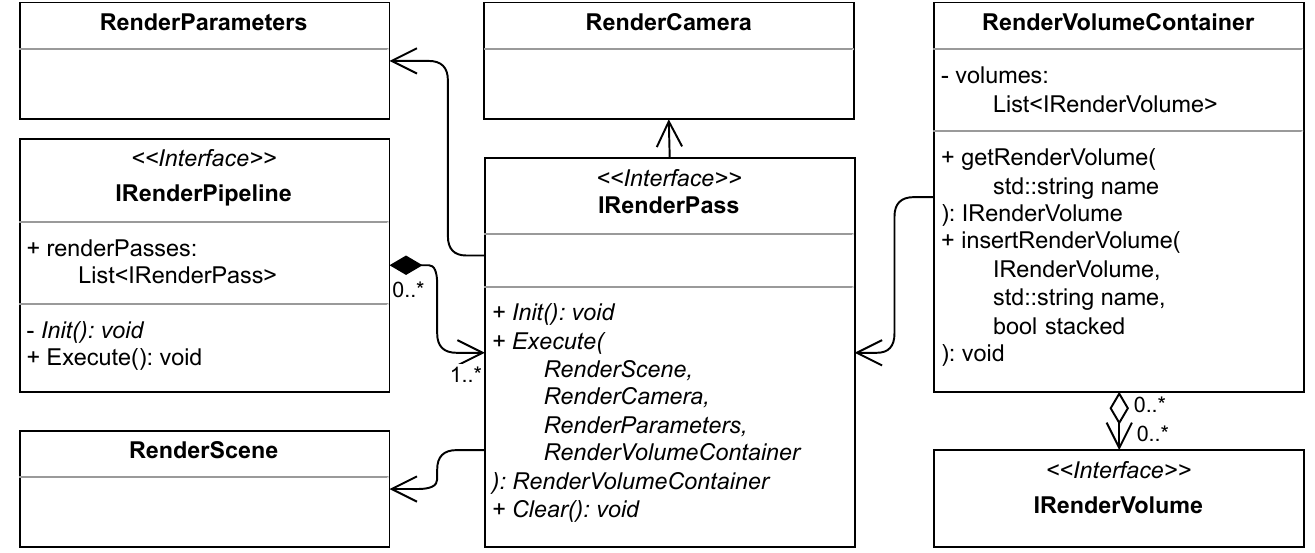
Figure 3. The class hierarchy of the rendering